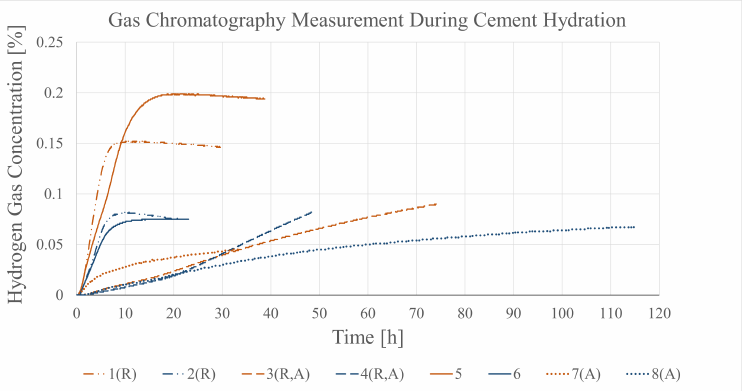
Figure 3. The hydrogen gas development of the aluminum samples embedded in a cement paste with 51% calcined kaolinitic clay during the cement hydration. The blue curves represent samples from the right arm, and the orange curves samples from the left arm of the lattice. The line style differentiates between the sample conditions.